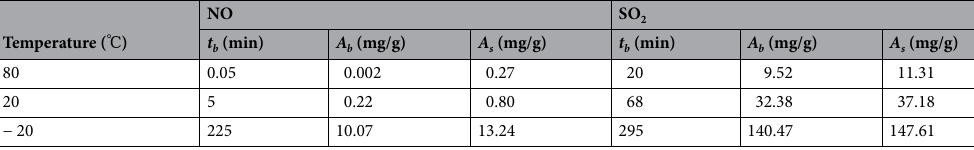
Table 3. Adsorption capacity of SO 2 and NO co-adsorption over CAC at various temperatures (simulated flue gas: SO 2 = 1000 ppmv, NO = 200 ppmv, O 2 = 6 vol.%, CO 2 = 12 vol.%, space velocity = 5000 h −1 ).